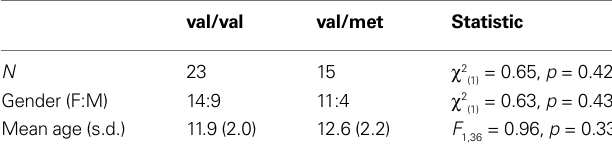
Table 1 | Participant demographics and summary